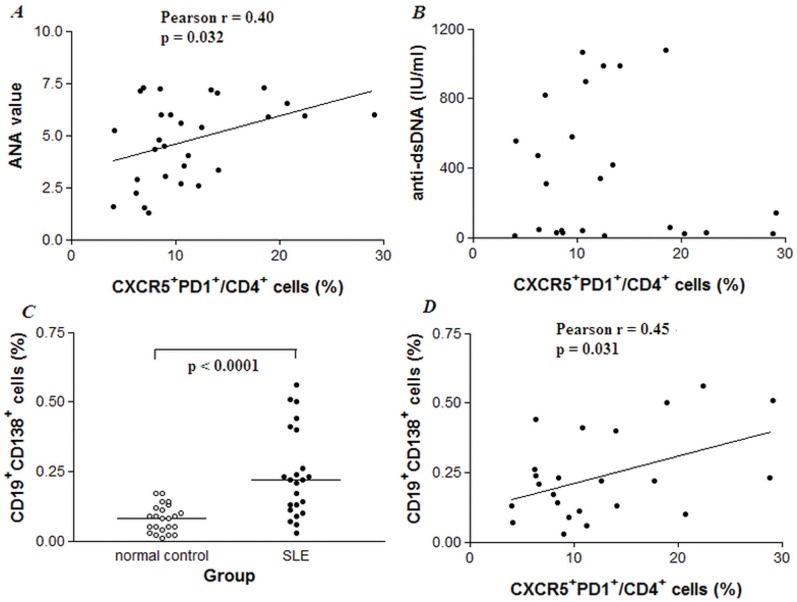
Positive correlation of CXCR5+ PD1+/CD4+ cells with ANA and CD19+ CD138+ cells in SLE patients. A. Percentages of circulating CXCR5+ PD1+/CD4+ cells were positively correlated with ANA values (Pearson r = 0.40, p<0.05) in 29 SLE patients. B. There were no association between percentages of CXCR5+ PD1+/CD4+ cells and circulating levels of IgG anti-dsDNA by Pearson correlation test. However, in those patients having high levels of anti-dsDNA antibodies (∼ 50%), a trend of correlation with CXCR5+ PD1+/CD4+ cells was observed. C. Circulating CD19+ CD138+ cells were elevated in SLE patients as compared with normal controls. Each symbol represented an individual sample, horizontal lines showed median values, and Mann-Whitney U test was applied. D. Percentages of CXCR5+ PD1+/CD4+ cells were positively correlated with percentages of CD19+ CD138+ cells in 23 SLE patients (Pearson r = 0.45, p<0.05).